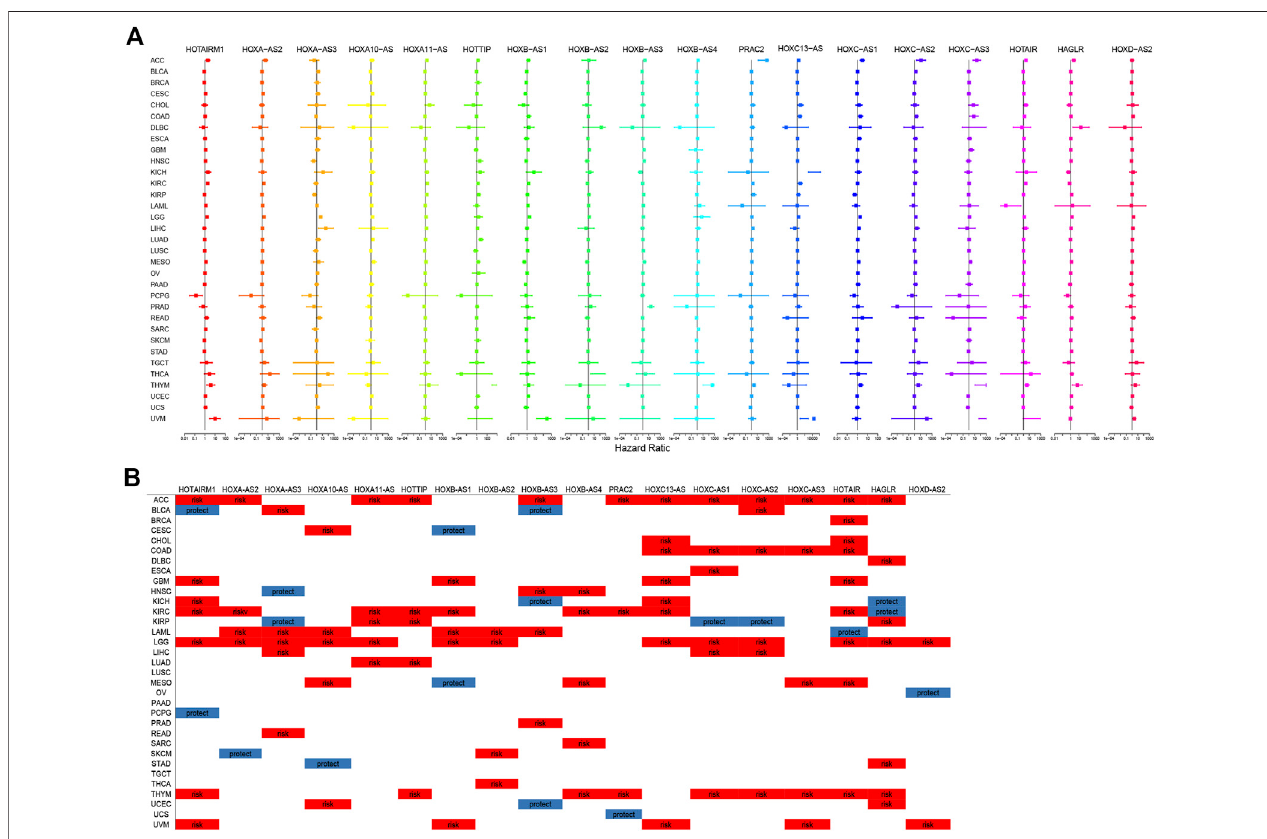
FIGURE 2 | Correlation between the homeobox antisense transcripts (HOXATs) expression and the overall survival (OS). Relationship between the HOXATs gene expression and the OS in patients with different cancer types. Forest plots of the hazard risk (HR) with 95% con fi dence intervals in the OS across different cancer types showed an advantage (HR < 1) and a disadvantage (HR > 1) in survival with increasing HOXATs expression (A, B) . Statistical signi fi cance was set at p <